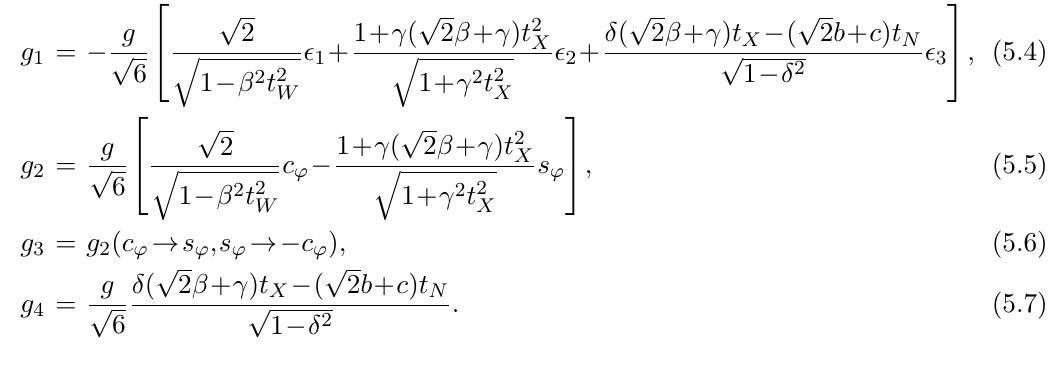
1 / √ 3 , γ = √ 2 / √ 3), and ( β = −